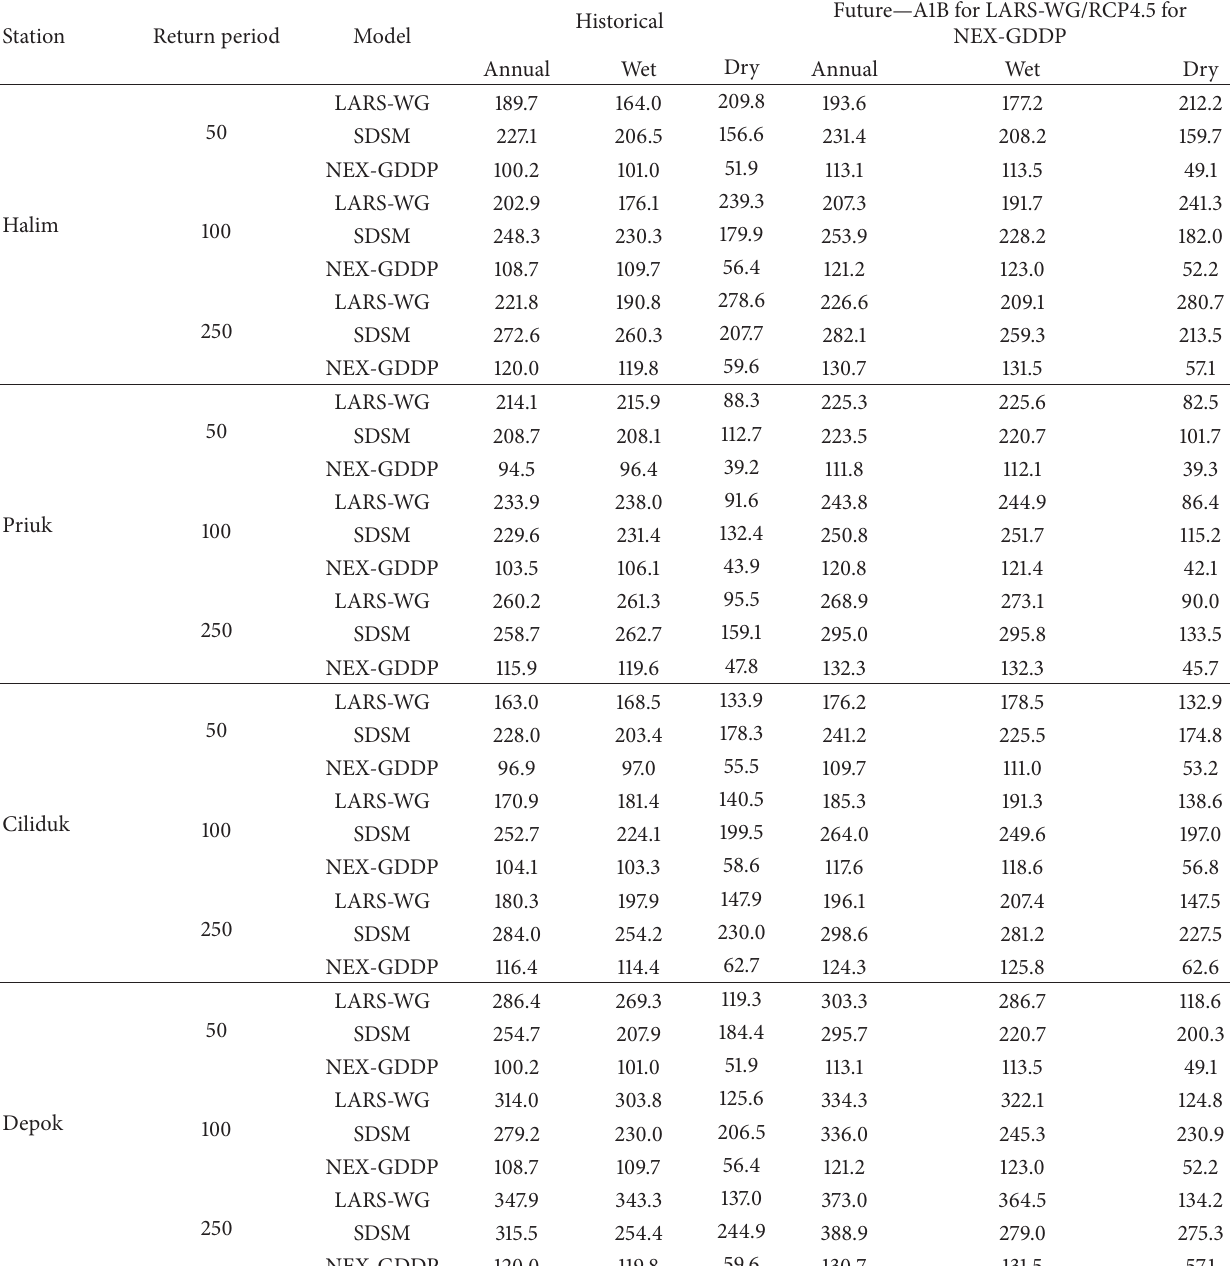
Table 5: Daily rainfall from annual and seasonal analysis for historical and future time periods.